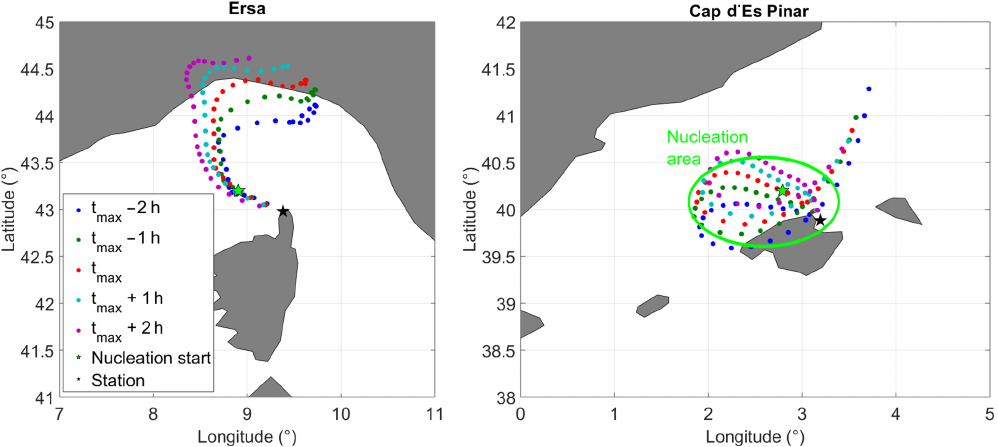
Figure 9. Back trajectories of air masses sampled in Ersa and Cap d’Es Pinar on 9 August at t max , when 20nm particles concentration is maximum, and during the 2h that precede and follow this maximum. The location where nucleation initially occurs upstream of the station is marked with a green